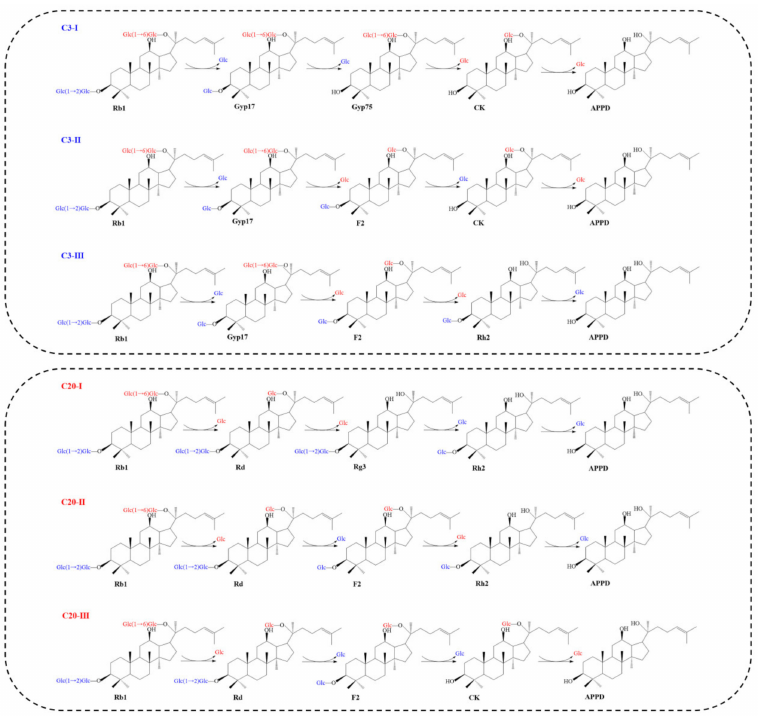
Figure 4. Enzymatic conversion pathways of ginsenoside Rb1. The chemical structure and conversion pathways were drawn by the ChemDraw